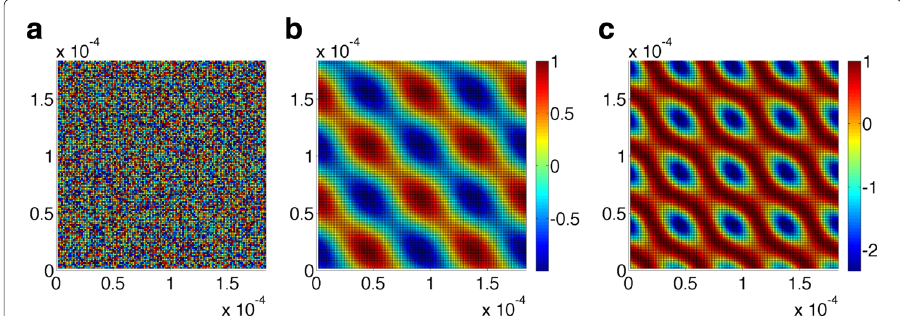
Fig. 10 Height data for the surface profiles of the ( a ) original surface prior to evolution, and surface after 60 h of evolution using ( b ) the linear evolution equation and ( c ) nonlinear evolution equation at θ = 45°. The surface height is normalized to the maximum height, where the peaks are shown by the red regions while the troughs are shown as blue . The x - and y-axes are expressed in [m] to show the feature size. The evolution parameters are as shown in Table 1. Both evolution regimes produce dots-on-ripples patterns, with contrasting